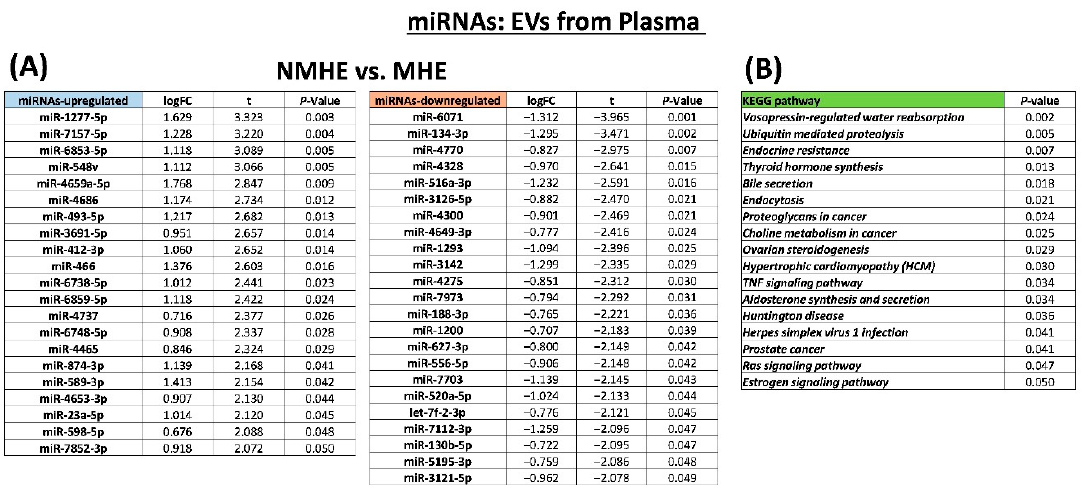
Figure 3. The miRNAs of EVs purified from plasma and differently expressed in patients with MHE. ( A ) List of the upregulated and downregulated miRNAs in EVs from MHE and obtained as indicated in the methods. ( B ) The KEGG pathways obtained from the target genes of miRNAs with differential expression in MHE as indicated in the methods. NMHE, MHE, patients without and with minimal hepatic encephalopathy, respectively.